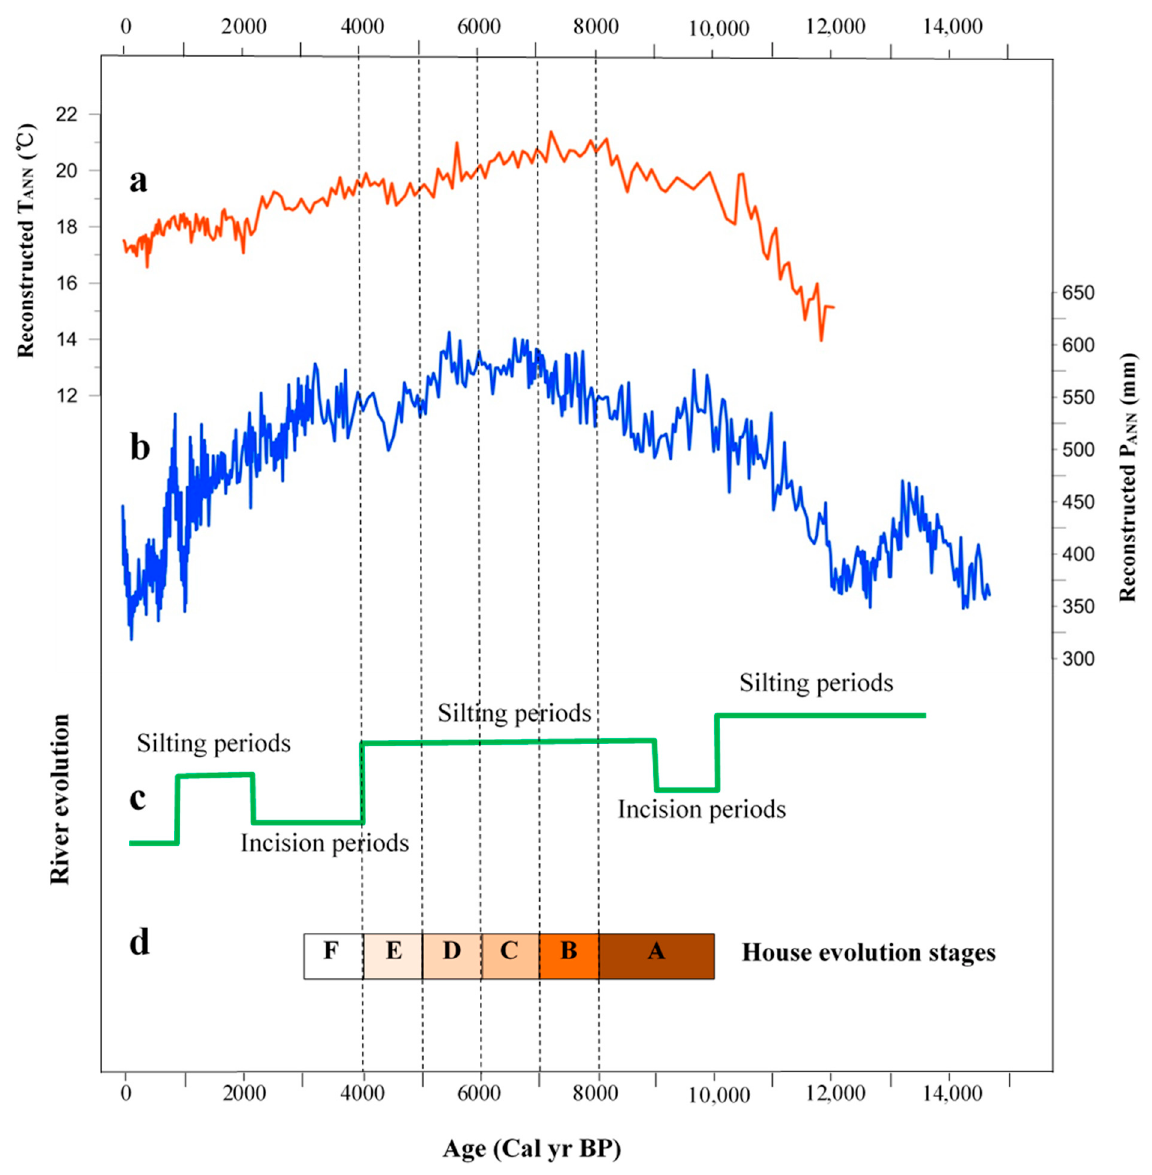
Figure 6. The relationship between house evolution and the Holocene environment: ( a ) temperature reconstruction, it citesfrom Chen et al (2015) [49]; ( b ) precipitation reconstruction, it cites from Marcott et al (2013) [50]; ( c ) fluvial geomorphic evolution; ( d ) house evolution. (A) The emergence of permanent settlements; (B) small semi pithouse without walls; (C) medium semi pithouse with low walls and surface buildings with wood skeleton mud walls; (D) ultra-large house emergence; (E) form diversification; (F) palace emergence and the formation of regional residential forms.